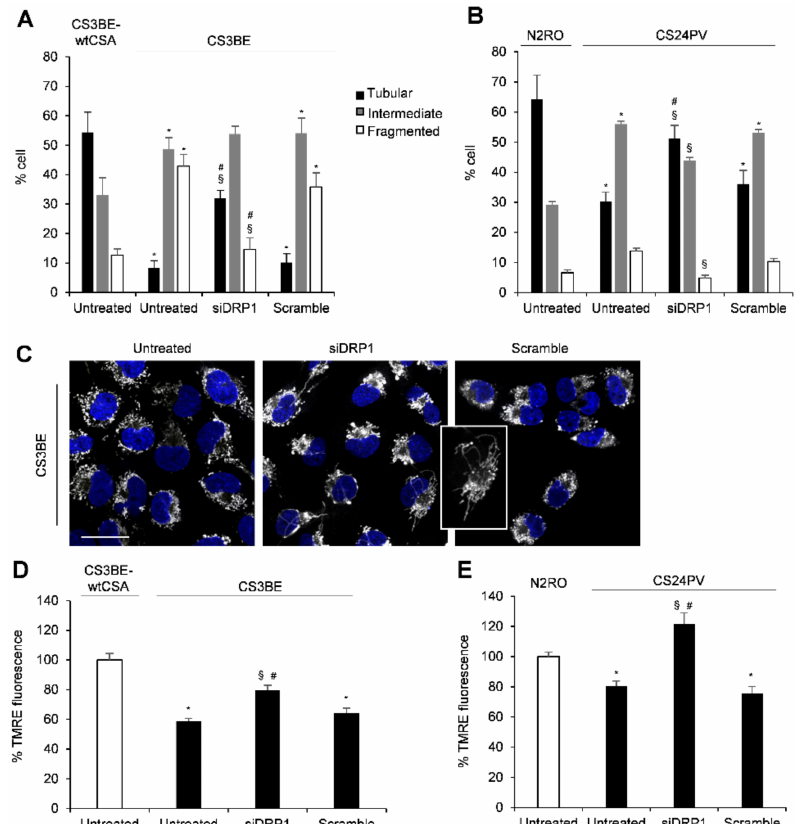
Figure 3. DRP1 silencing ameliorates mitochondrial phenotype in CS3BE cells. ( A , B ) Distribution of cell percentage according to mitochondrial morphology in SV40-trasformed cells (CS3BE-wtCSA and CS3BE), and normal (N2RO) and CS-A (CS24PV) primary fibroblasts. The reported values represent the mean ± SEM of four independent experiments; * p < 0.05 vs. CS3BE-wtCSA and N2RO cells; § p < 0.05 vs. untreated CS3BE or CS24PV cells; # p < 0.05 vs. scramble CS3BE or CS24PV cells. ( C ) CLSM examinations (three-dimensional reconstruction images) of CS3BE cells: untreated (left), silenced (middle) and scramble (right). To detect mitochondria, living cells were stained with Mitotracker ® Deep Red FM (pseudo-color gray) and then fixed. Nuclei were stained with DAPI (blue). Scale bars, 20 µ m. Panels are representative of two independent experiments. ( D , E ) Mitochondrial membrane potential expressed as percentage of TMRE-fluorescence intensity in SV40-trasformed cells (CS3BE-wtCSA and CS3BE), and normal (N2RO) and CS-A (CS24PV) primary fibroblasts. The reported values represent the mean ± SEM of four independent experiments. The values obtained in CS3BEwtCSA and N2RO cells are taken as 100%. * p < 0.05 vs. CS3BE-wtCSA or N2RO; § p < 0.05 vs. untreated CS3BE or CS24PV cells; # p < 0.05 vs. scramble CS3BE or CS24PV